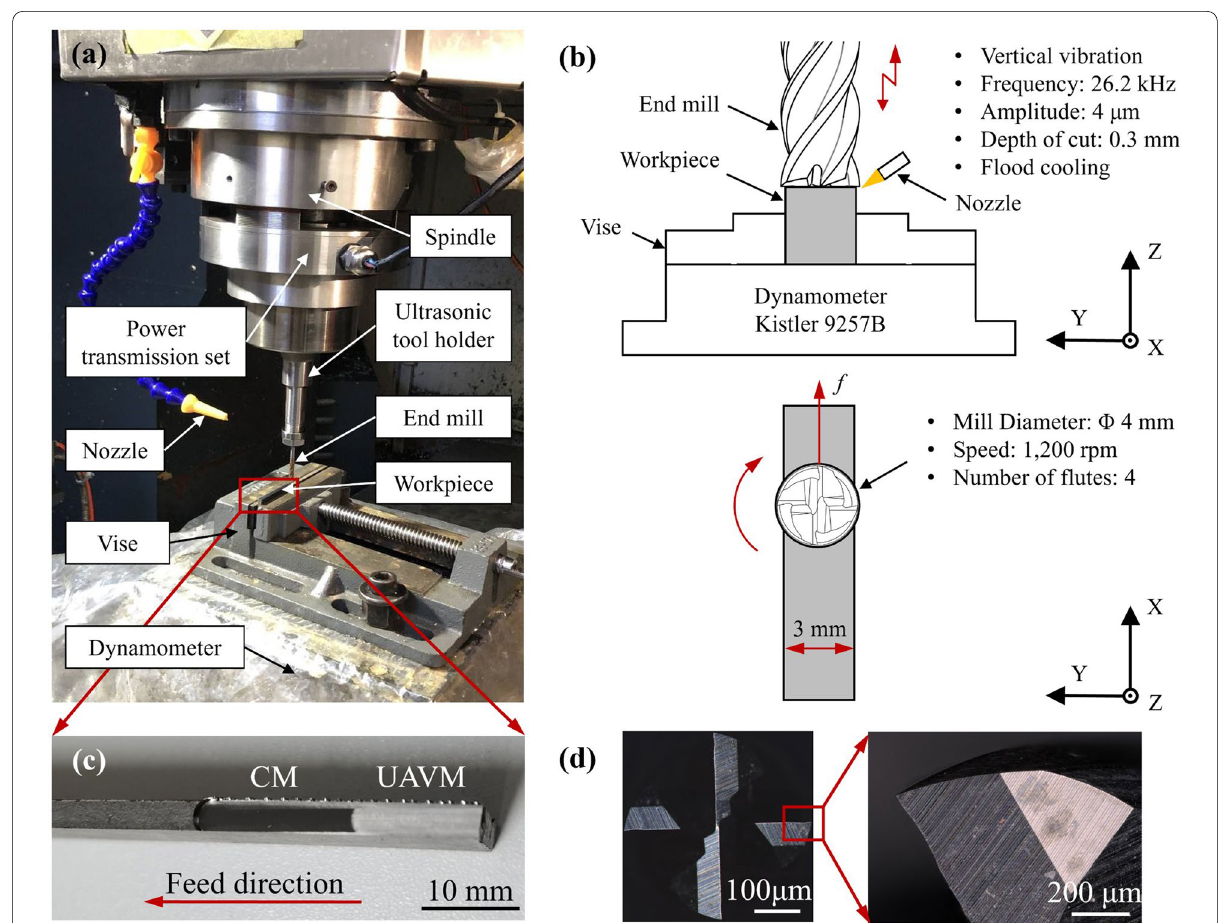
Figure 2 Experimental setup for the CM and UAVM: a picture of the UAVM setup, b schematic of the milling process, c the surfaces machined by the CM and UAVM, d the cutting edges of the end